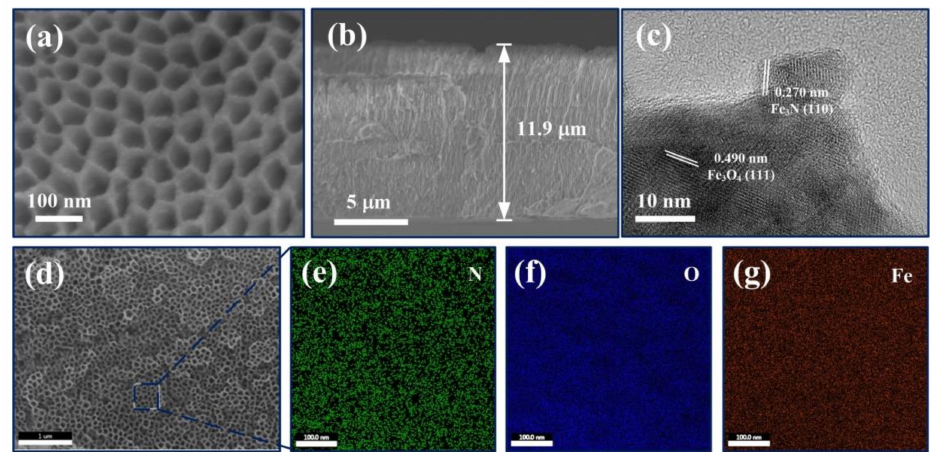
Figure 2. Characterization graphs of NASS-N samples. ( a ) High magnification SEM graph of the sample surface. ( b ) SEM graph of the sample side-wall. ( c ) TEM graph. ( d – g ) SEM-EDS